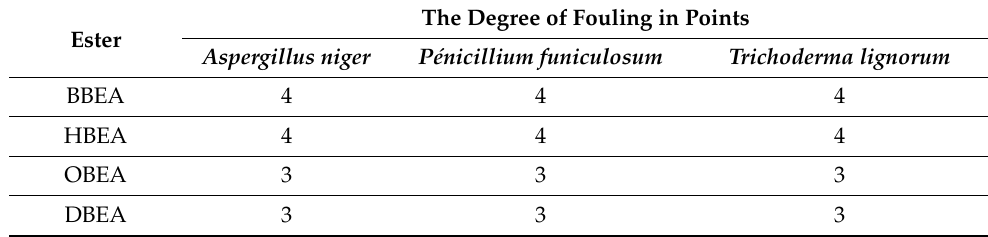
Table 4. Fungal resistance of alkyl butoxyethyl adipates. The Degree of Fouling in Points Ester Aspergillus niger P é nicillium funiculosum Trichoderma lignorum BBEA 4 HBEA OBEA